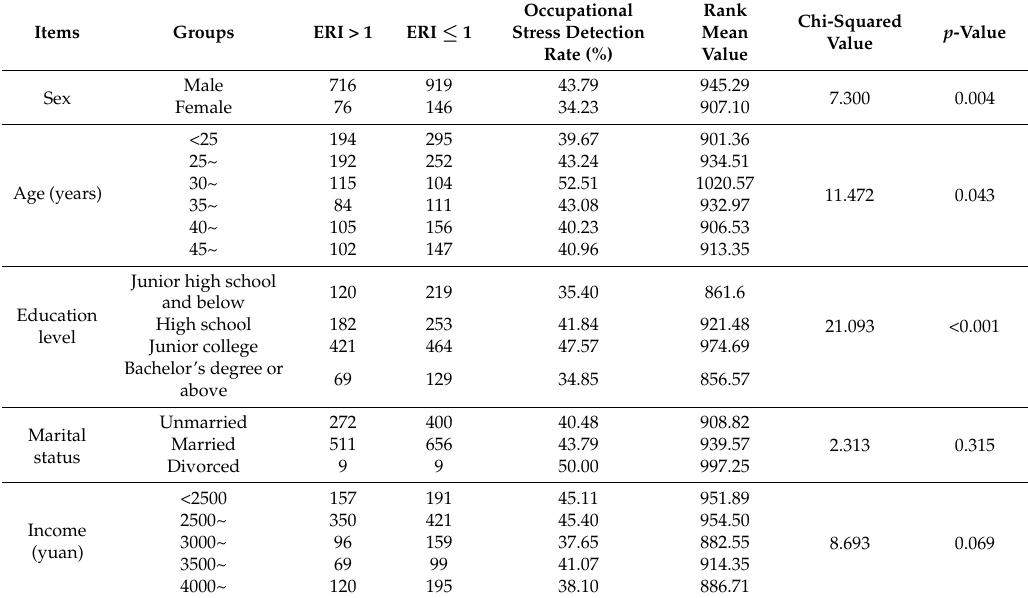
Table 2. Comparison of occupational stress levels in different populations. ERI: Effort–Reward Imbalance.